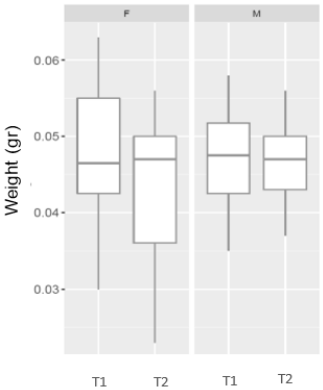
Figure A1. Adult fresh mass between trials (T1 = Trial1, T2 = Trial2) in females and males of Pieris napi .